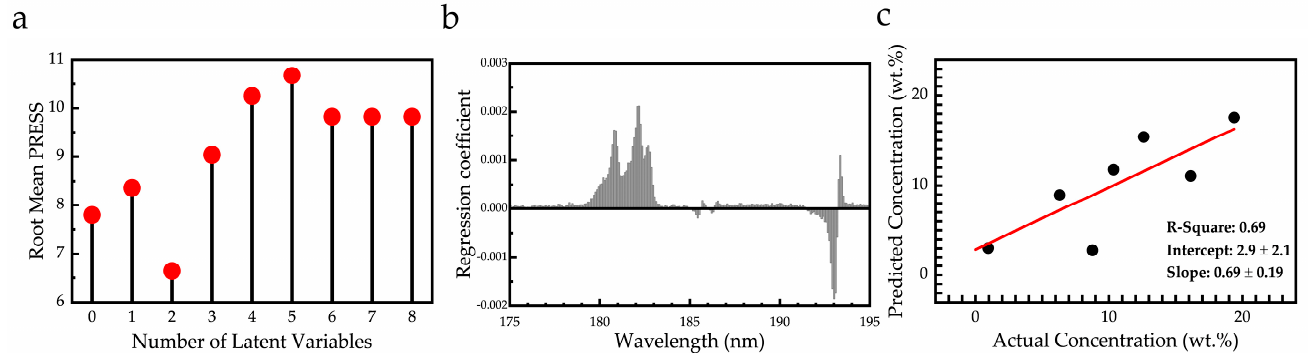
Figure 11. ( a ) Root mean prediction error sum of squares (PRESS) as a function of the number of the LVs. ( b ) Regression coefficients of each variable plotted versus wavelength. ( c ) Predicted versus actual value concentrations of the samples computed by partial least squares regression (PLS-R).